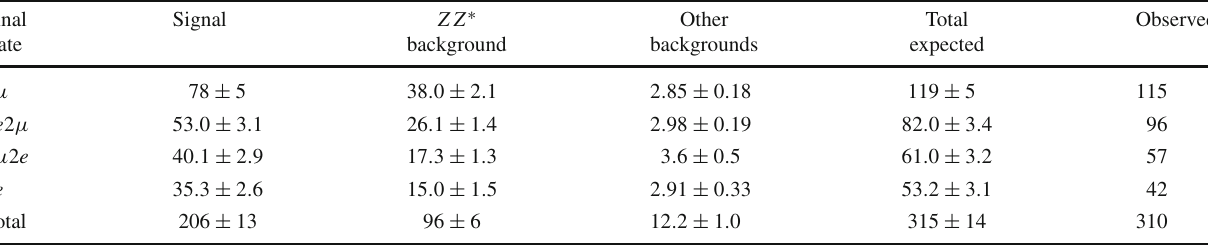
Table 6 Expected (pre-fit) and observed numbers of events in the four decay final states after the event selection, in the mass range 115 GeV < m 4 (cid:3) < 130 GeV. The sum of the expected number of SM